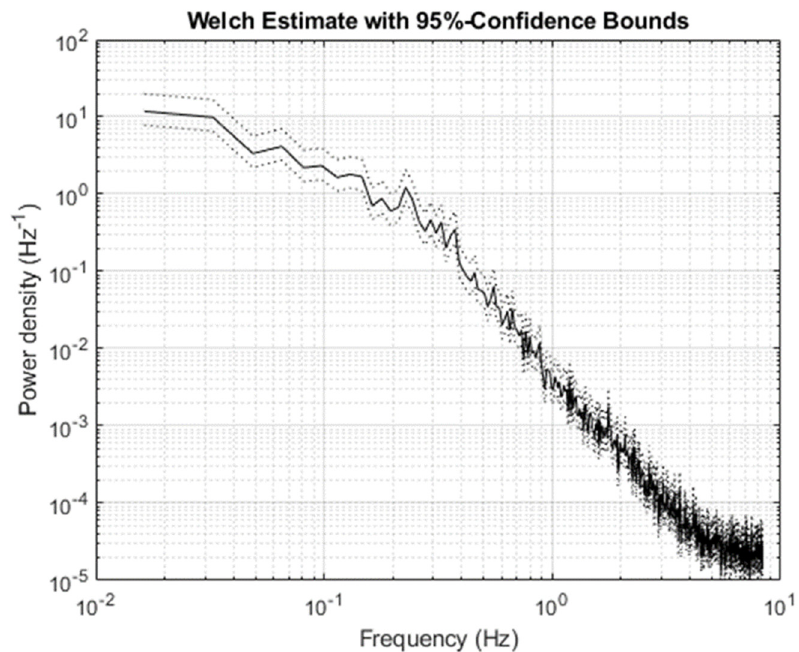
Figure 15. The variance-normalized power spectral density of salinity fluctuations shown in Figure 14 ( Ri initial = 100, Re = 214 ).